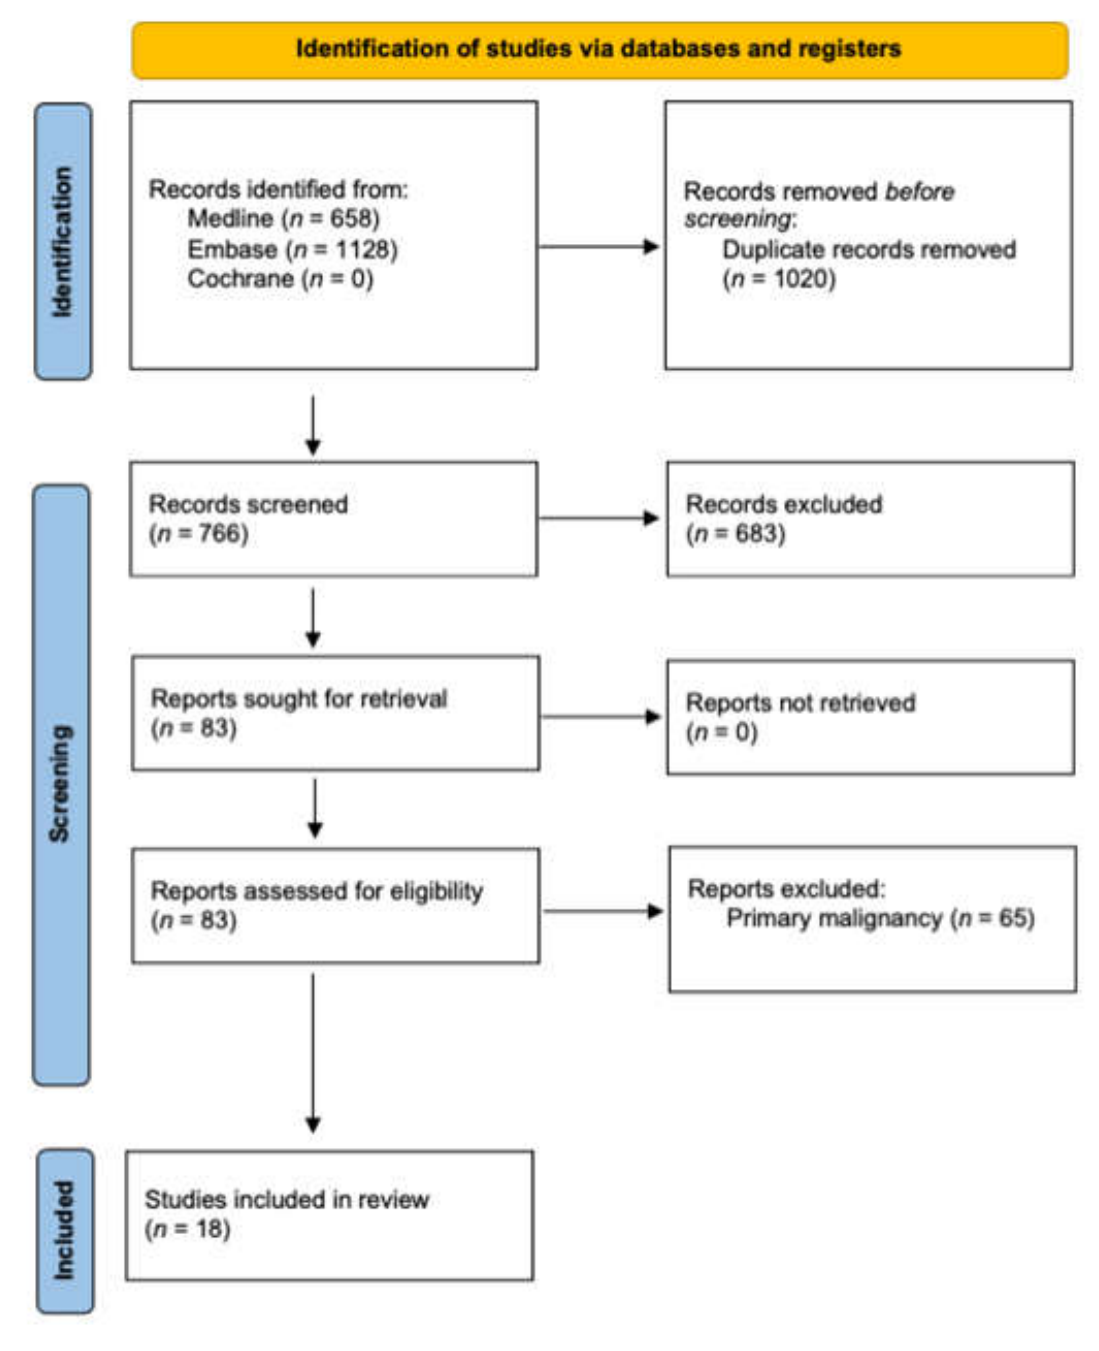
Figure 1. PRISMA flow